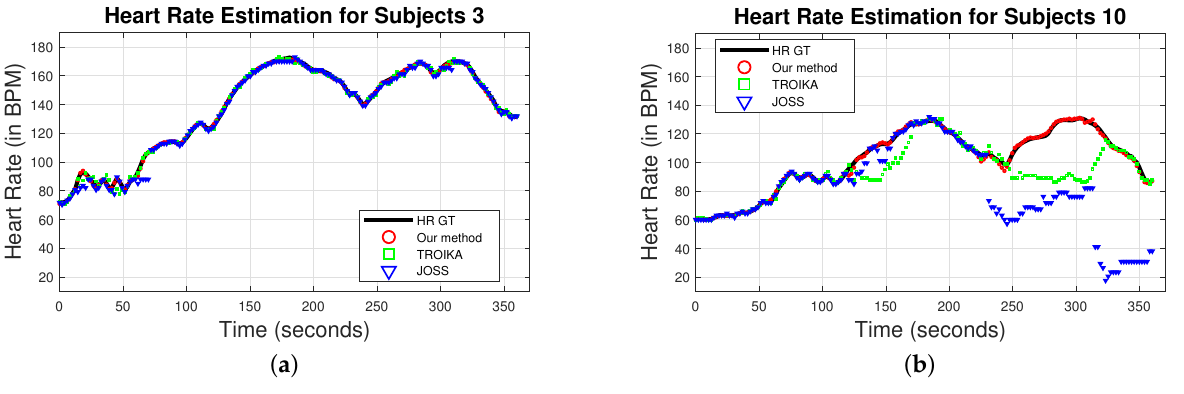
Figure 10. HR calculated for the whole experimental run using DWL method (red circles), TROIKA (green squares), and JOSS (blue triangles). ( a ) HR values for participant 3. DWL, TROIKA, and JOSS were able to calculate accurate heart rate levels. ( b ) HR values for participant 10. TROIKA lost track of the correct heart rate from 120 to 175 s and from 250 to 325 s. Similary, JOSS lost track of the correct heart rate from 225 s until the end of the experimental run. DWL methods was able to estimate the participant’s HR accurately during the whole experimental